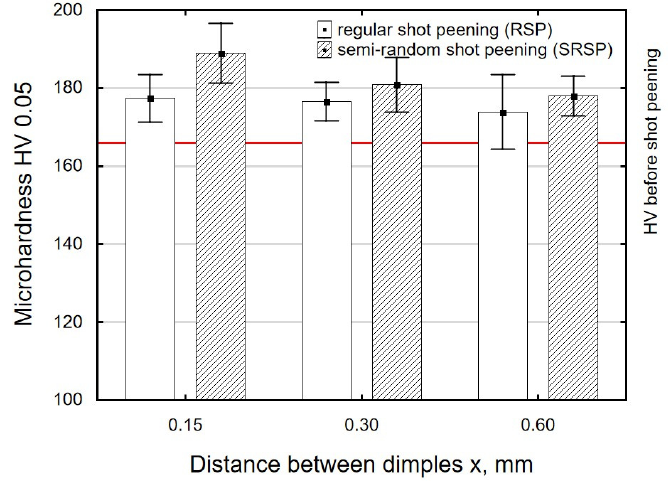
Figure 12. Distance between the dimples versus surface microhardness (impact energy E = 100 mJ, ball diameter D = 10 mm).